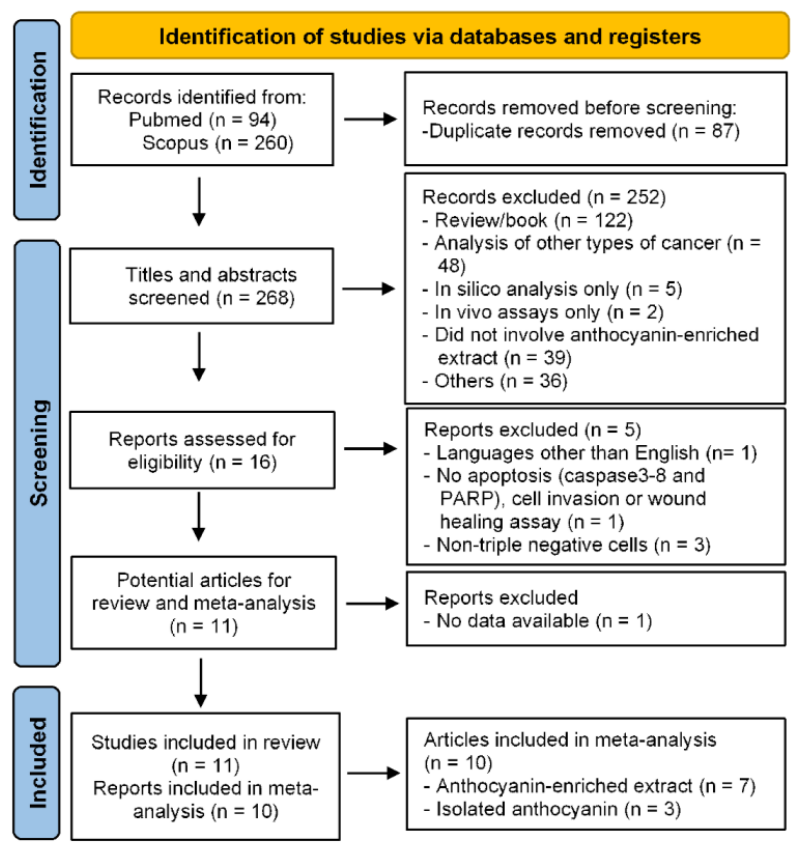
Figure 2. Flowchart showing the study selection process following the Preferred Reporting Items for Systematic Reviews and Meta-Analyses.